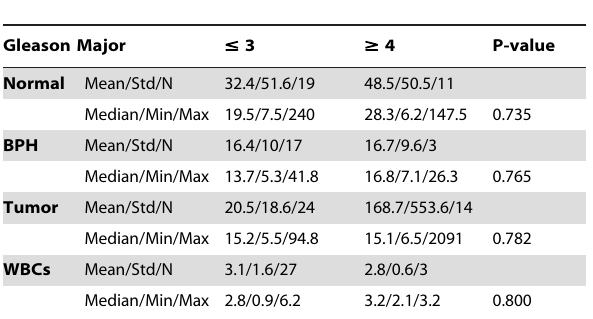
Table 6. Comparison of mtDNA content in normal, BPH, tumor, and WBCs between different Gleason grades (Gleason Major).